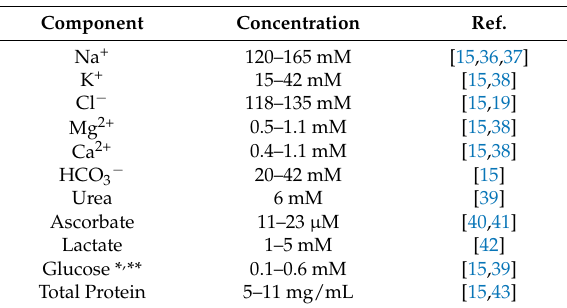
Table 2. Typical concentrations of tear fluid constituents.